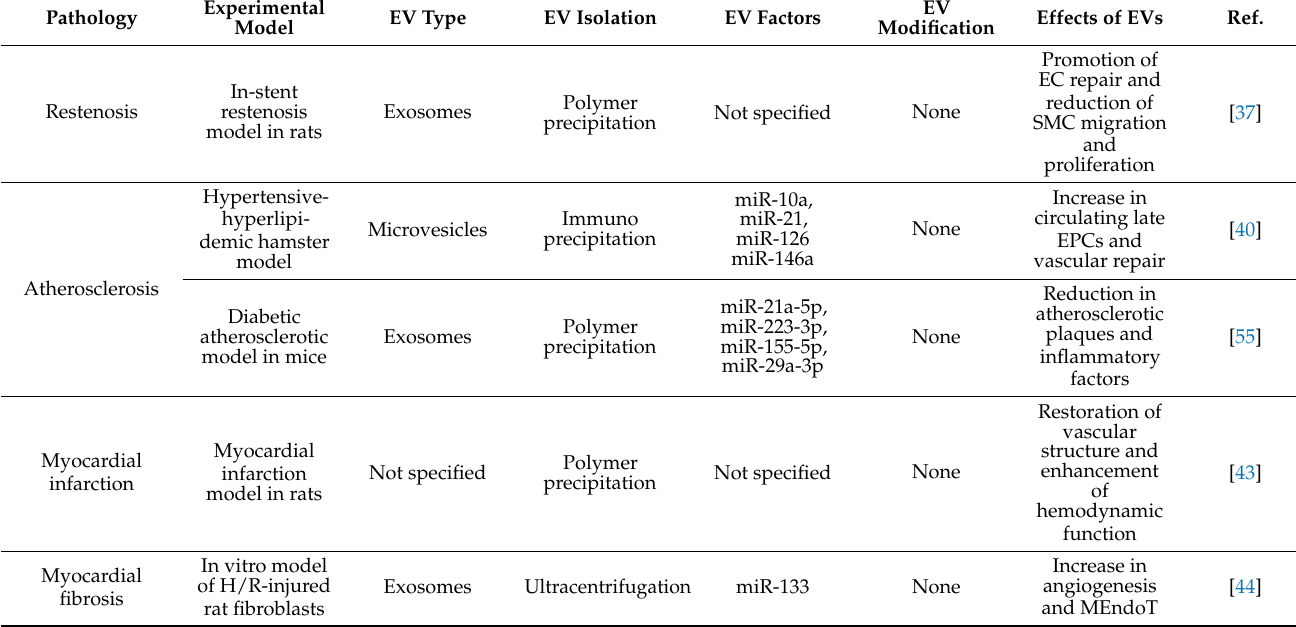
Table 1. Experimental cell-free strategies based on EPC-derived EVs in the treatment of tissue injuries.